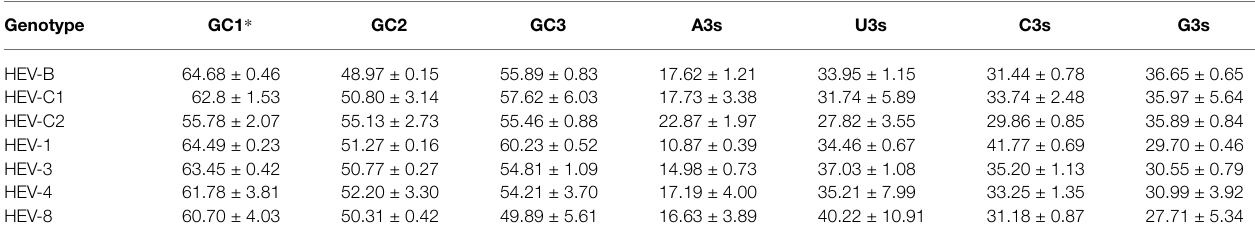
TABLE 1 | Nucleotide composition of complete genomes in seven HEV genotypes.